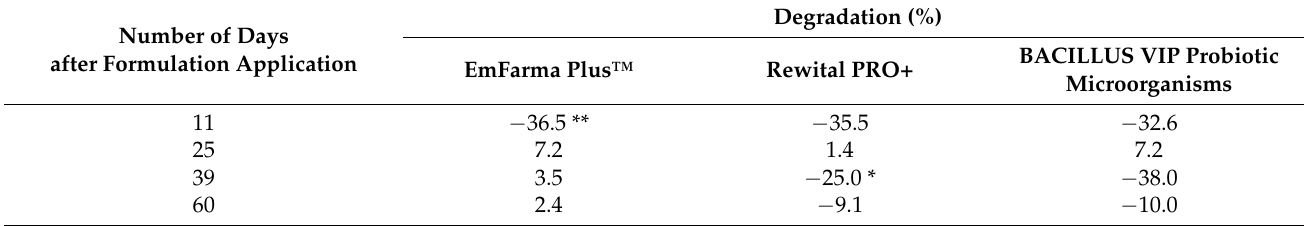
Table 1. Percentage diflufenican degradation following application of formulations containing EM versus control samples (the content of herbicide in control samples, on each sampling day, was assumed as 100%; ‘ − ’ means that the degradation rate decreased).